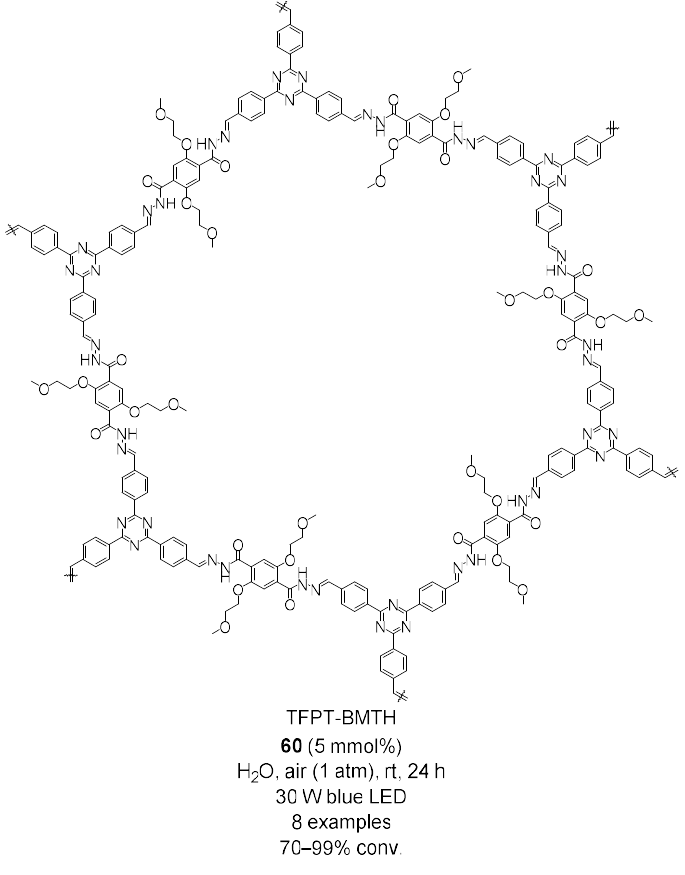
Figure 15. Results obtained in the aerobic photo-oxidative coupling of benzylamines to N -benzylidene benzylamines 2 catalyzed by 60 .